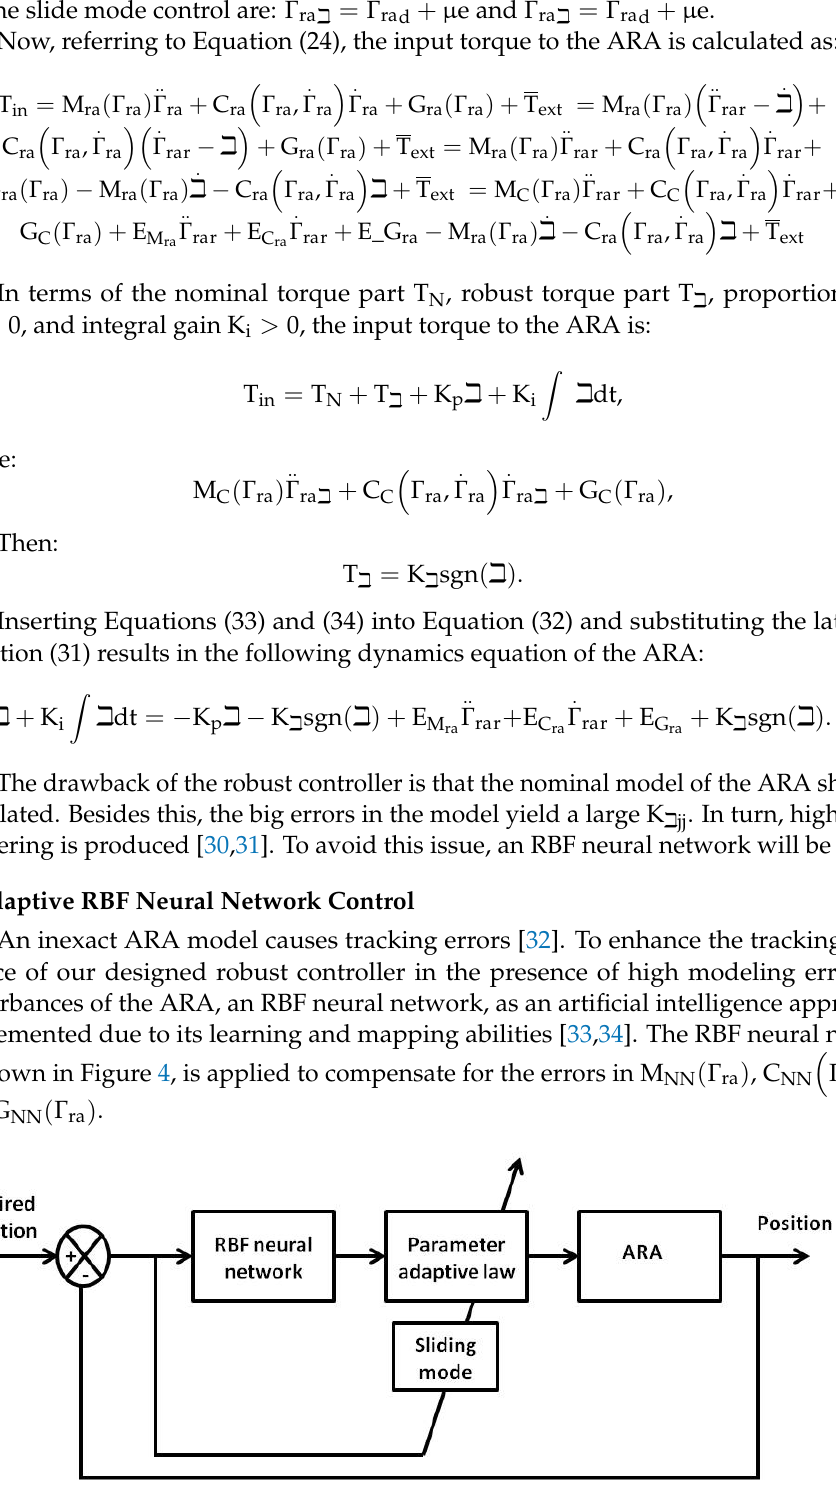
Figure 4. Block diagram of the proposed technique.